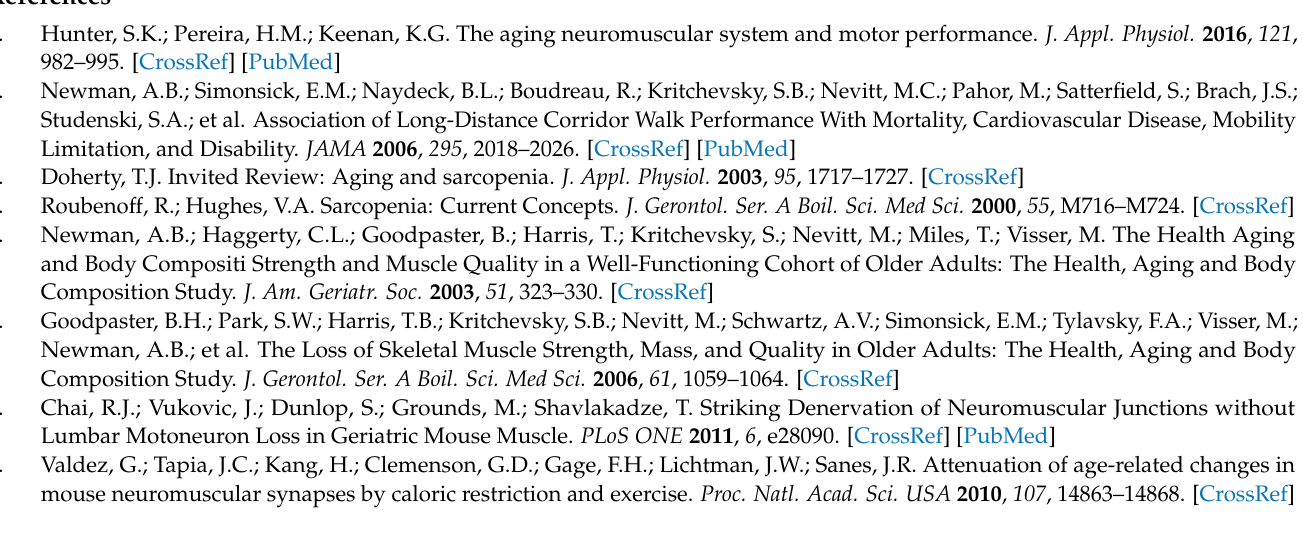
protein Dok-7 in skeletal muscles. Figure S2: Effect of MFGM supplementation from a young age on axon number. Figure S3: Effect of MFGM intake combined with exercise from an old age on caspase-3 expression in somata of motor